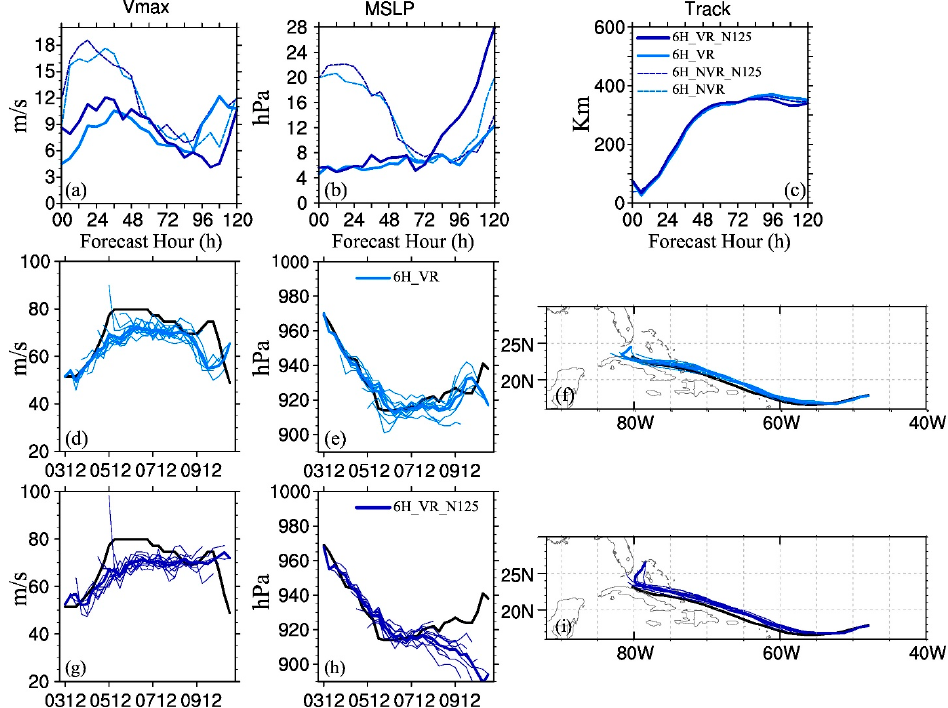
Figure 4. Same as Figure 2, except for “6H_VR” (solid turquoise), “6H_VR_N125” (solid blue), “6H_NVR” (dashed turquoise), and “6H_NVR_N125” (dashed blue). “6H_NVR” (dashed turquoise), and “6H_NVR_N125” (dashed